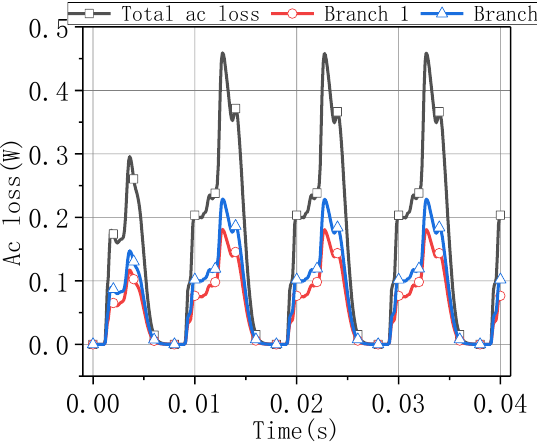
Figure 16. AC loss during rated operation.